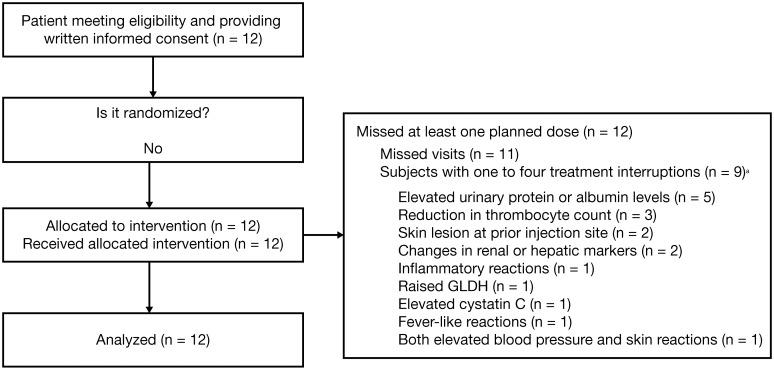
Patient flow diagram.aExcluding planned washout and off-drug periods.